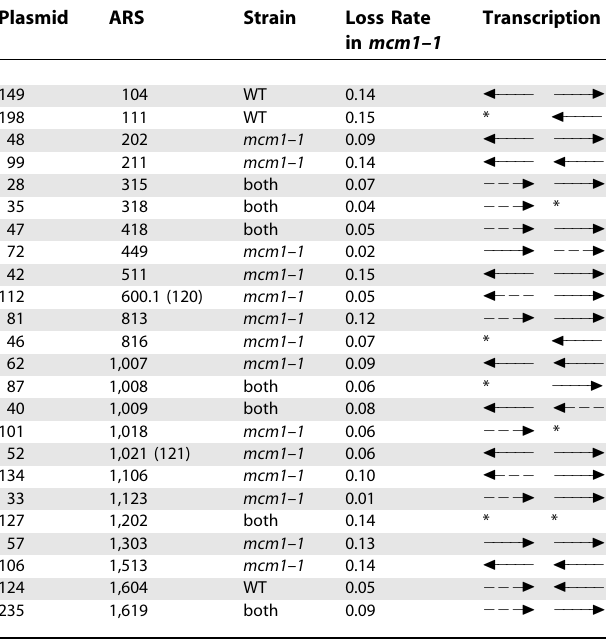
Dashed arrows indicate genes that are not present due to promoter deletion during the library construction. Asterisks indicate features other than genes. DOI: 10.1371/journal.pgen.0020141.t003